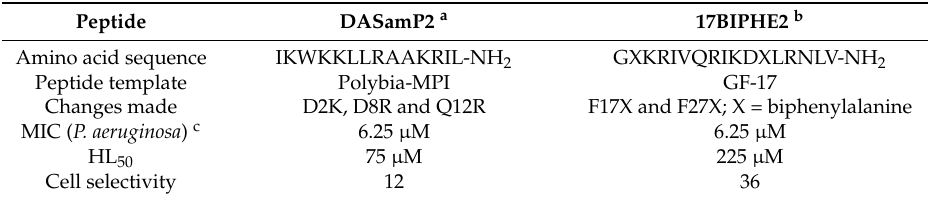
Table 1. Properties of DASamP2 and